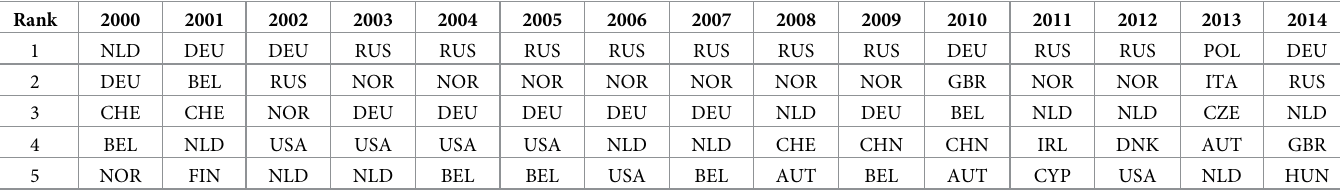
Table 3. Five highest-potential countries in European community.